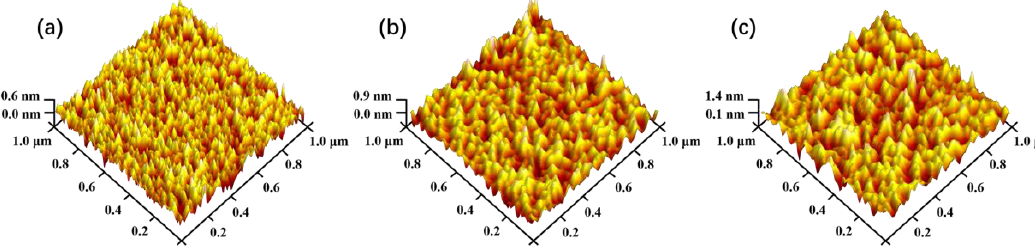
Figure 3. Three-dimensional morphology of the ( a ) SiON-1, ( b ) SiON-1, and ( c ) SiON-3 thin film by AFM.